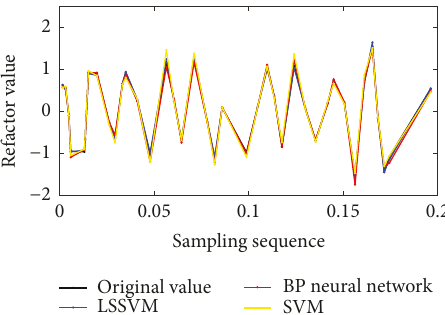
Figure 16: The value of correcting outlier by three